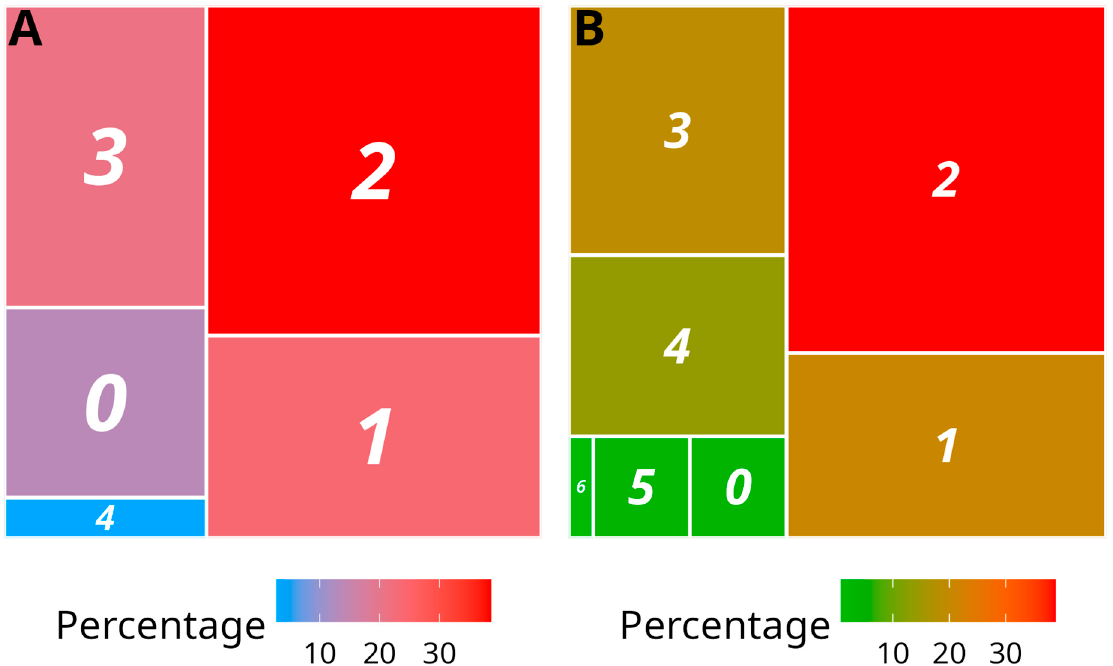
Figure 3. Treemap representation of the infection status of analysed yam samples. ( A ) Samples collected in 2019 from 18 plots and 6 yam species, indexed for CoV1, DMaV, YaV1, YMV, YMMV, macluraviruses and potexviruses. ( B ) Samples collected in 2020 from 2 plots (Godet and Roujol) and one yam species, D. alata , indexed for CoV1, DMaV, YaV1, YMV, YMMV, badnaviruses, macluraviruses and potexviruses. The number of distinct viruses detected is shown in the colour boxes, ranging from 0 (no virus detected) to 6 (sextuple infection). The size and colour of the boxes reflect the percentage of samples in each category. A colour scale is provided under the treemaps.